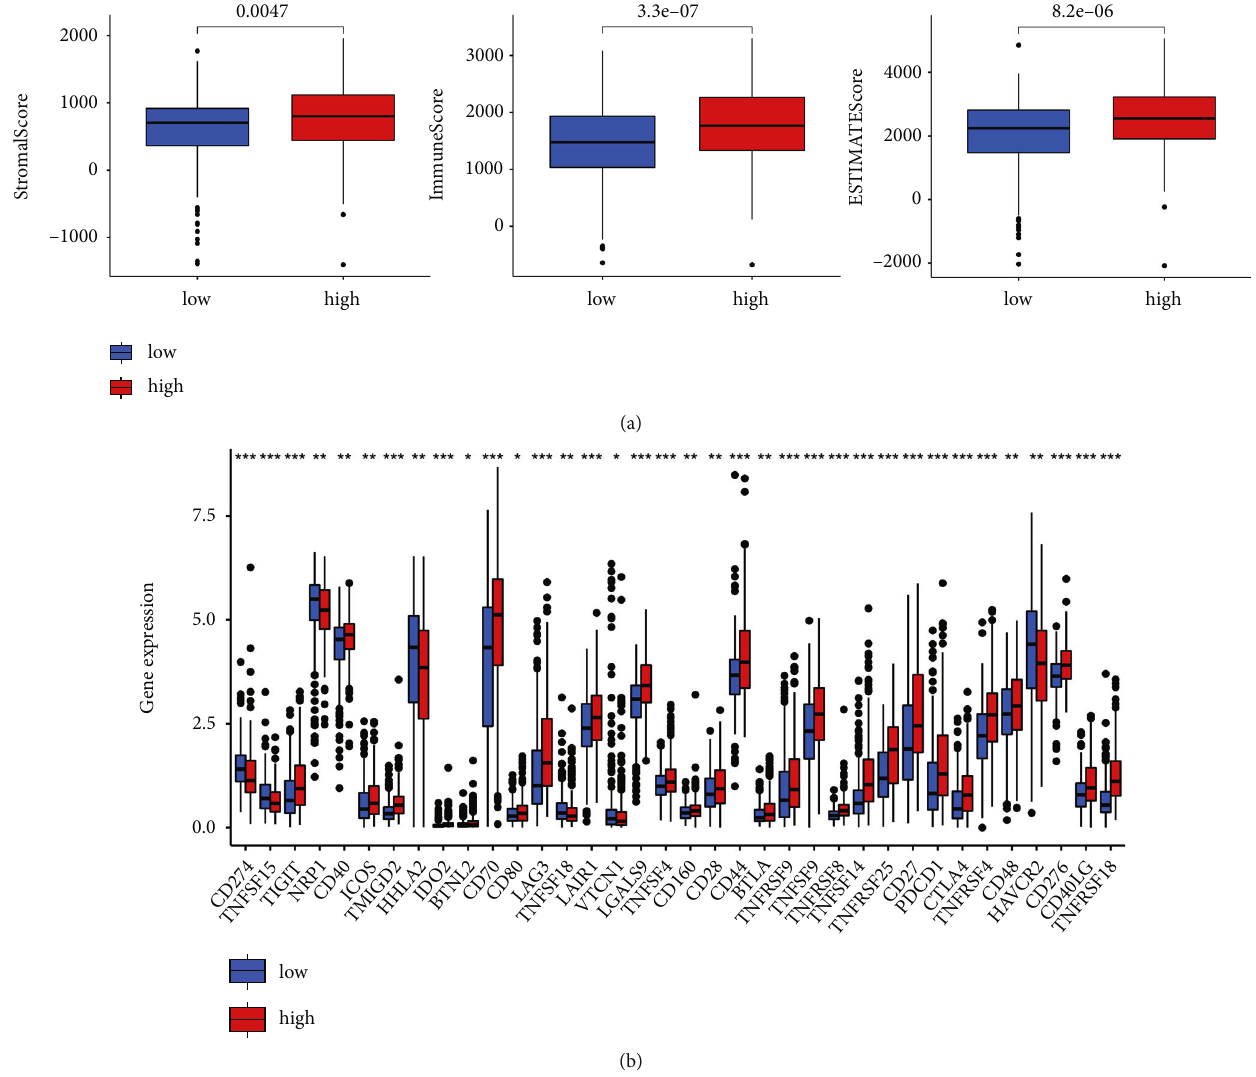
Figure 8: The tumor immune microenvironment and immune checkpoints between the two groups. (a) Boxplots of StromalScore, ImmuneScore, and ESTIMATE Score between the two groups. (b) Immune checkpoint expressions between the two groups. * p < 0 : 05 , ** p < 0 : 01 , and *** p < 0 : 001